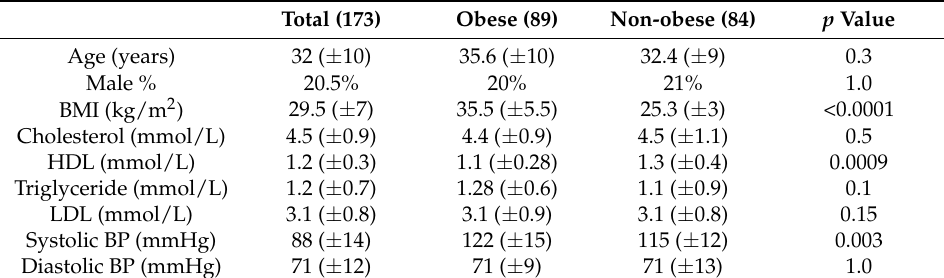
Table 1. Characteristics of the study participants.